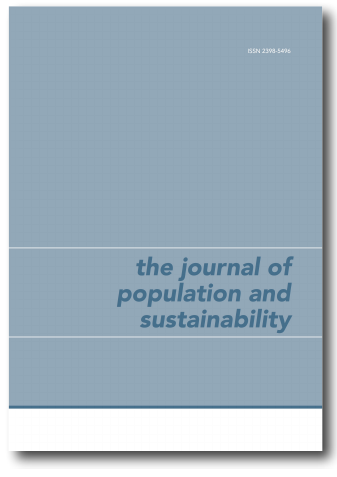
Article title: A tale of two islands. The reality of large-scale extinction in the early stages of the Anthropocene: a lack of awareness and appropriate